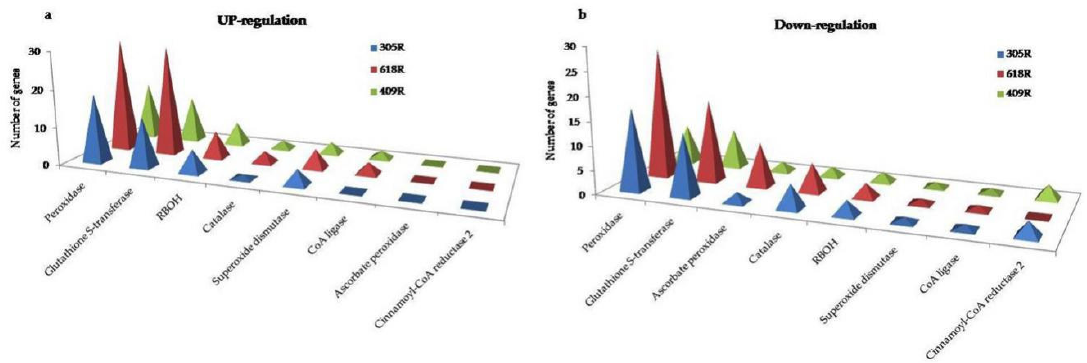
Figure 5. Comparative identification of DEGs related to secondary metabolites, reactive oxygen species (ROS), and antioxidants in pyramided and parental lines. ( a ) Up-regulated genes. ( b ) Down-regulated genes.